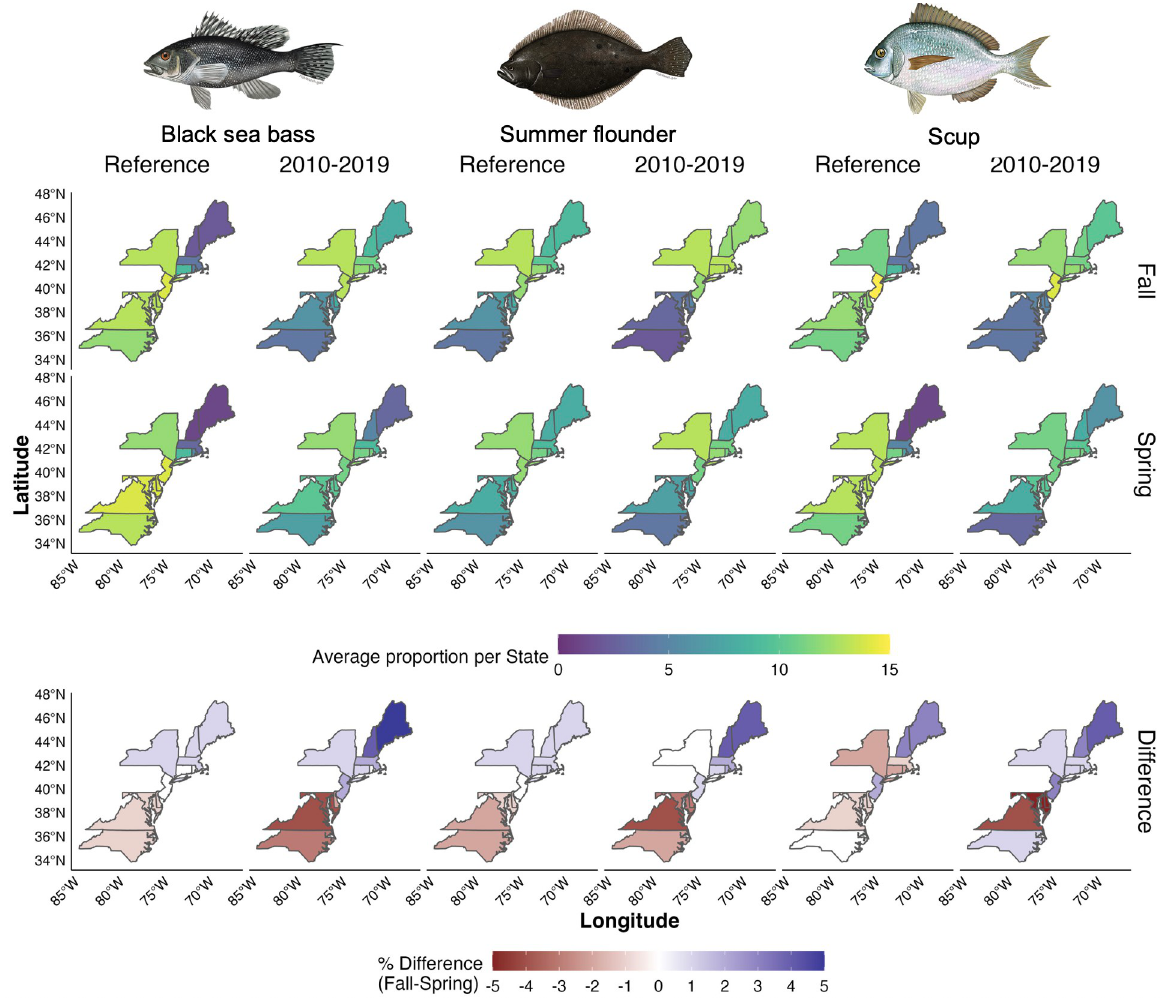
Fig 5. Proportion of trawl survey data as Catch Per Unit of Effort (CPUE) for each state and species by survey season. Top and middle rows represent fall and spring surveys, respectively. Bottom row is the difference between both approaches ( Δα units. Fish images from MAFMC